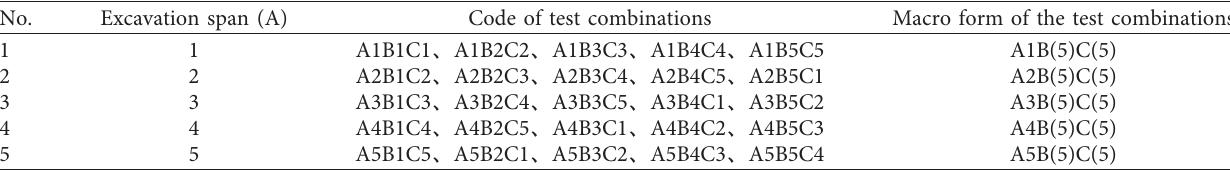
Table 7: Macro form of test combination at each level of factor A.